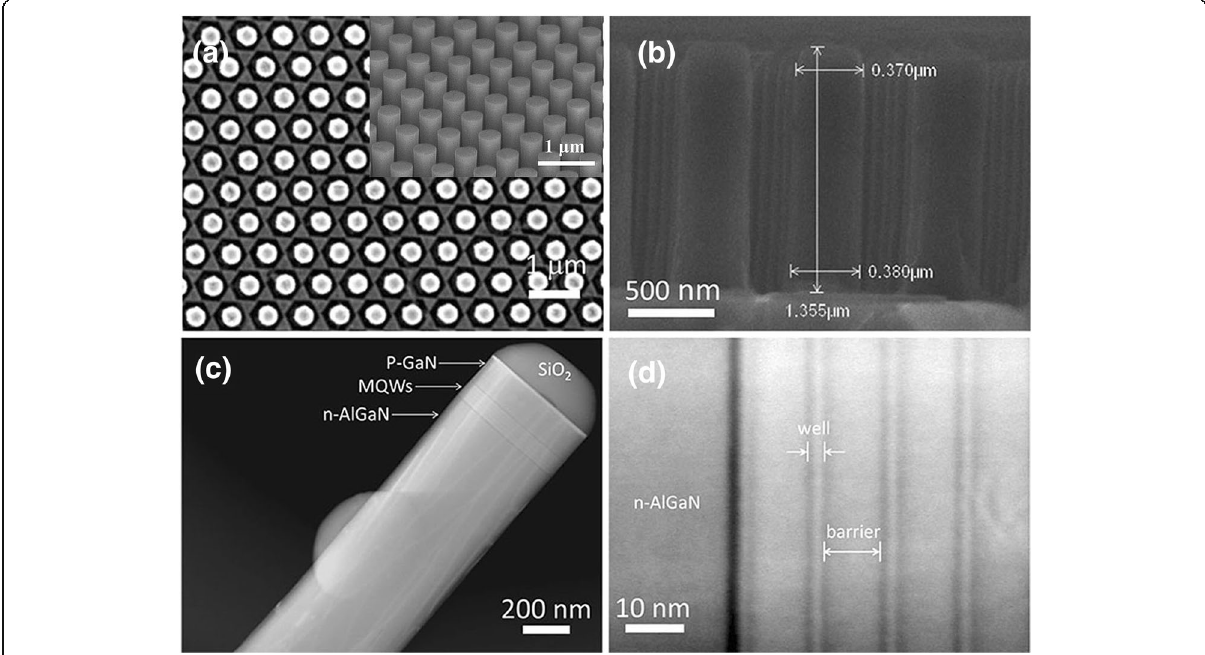
Fig. 2 The top view ( a ), titled (inset in a), and cross-sectional ( b ) SEM images of the AlGaN NR arrays. c , d the TEM images of single NR and AlGaN MQWs, respectively